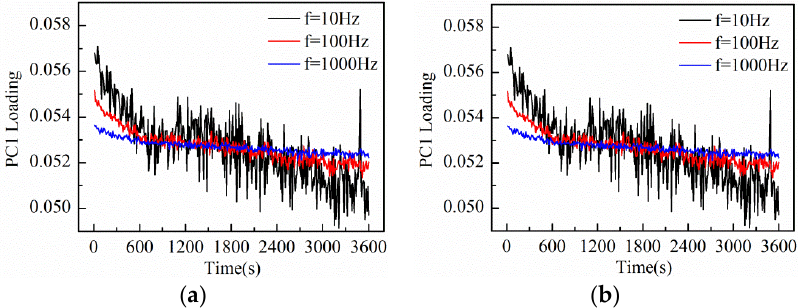
Figure 6. Measurement results of KCl base solution conducted with Au-IDT excited by triangular waveform voltage of different parameters: ( a ) A = 0.2 V; ( b ) A = 1 V. waveform voltage of different parameters: ( a ) A = 0.2 V; ( b ) A = 1